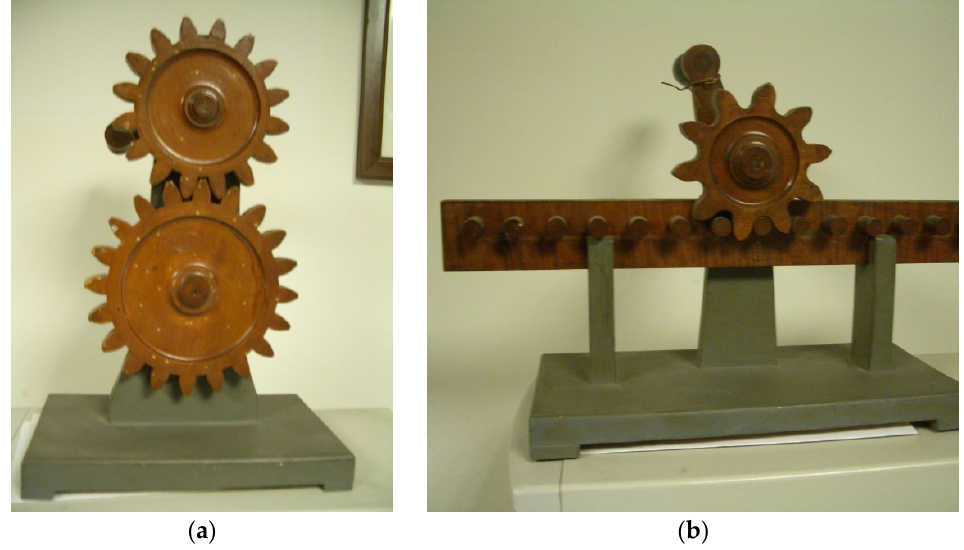
Figure 10. Examples of wood models stored as in Figure 9: ( a ) two-circular gear transmission; ( b ) gear-rack transmission.